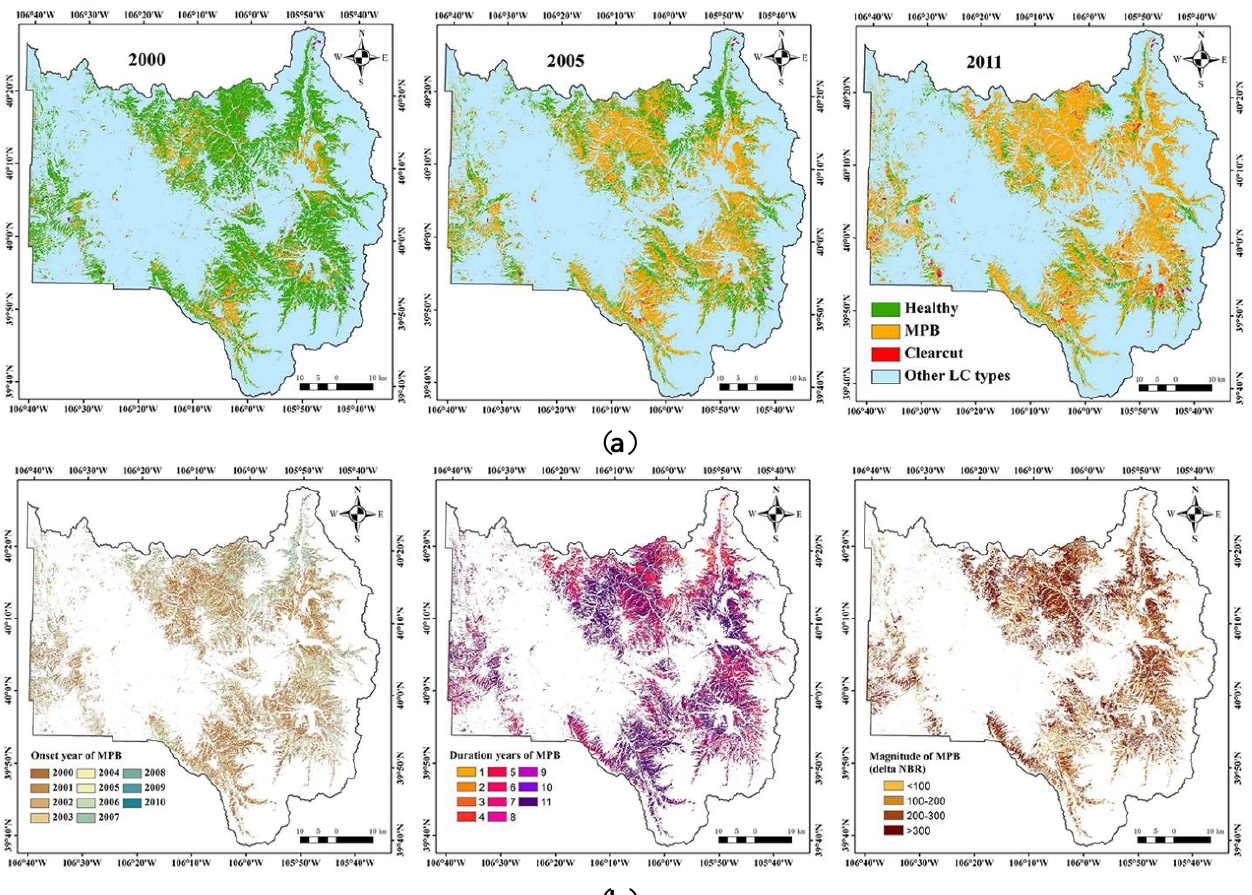
Figure 6. ( a ) Classification results of the forest growth trend analysis in the years 2000, 2005 and 2011; ( b ) maps of the onset year, duration and magnitude of mountain pine beetle (MPB)